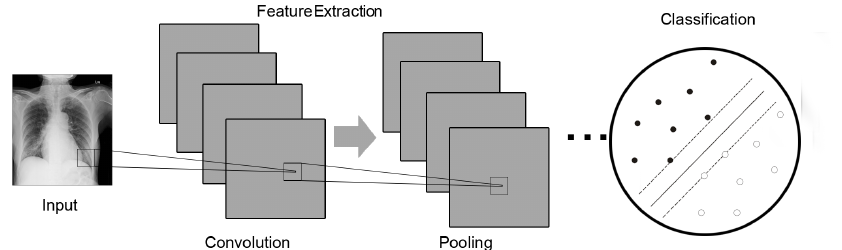
Figure 8. Convolution support vector machine (CSVM) architecture. Source: prepared by the authors and inspired by